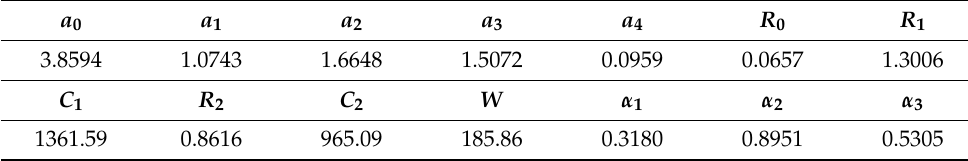
Table 1. The results of PI with the GA.